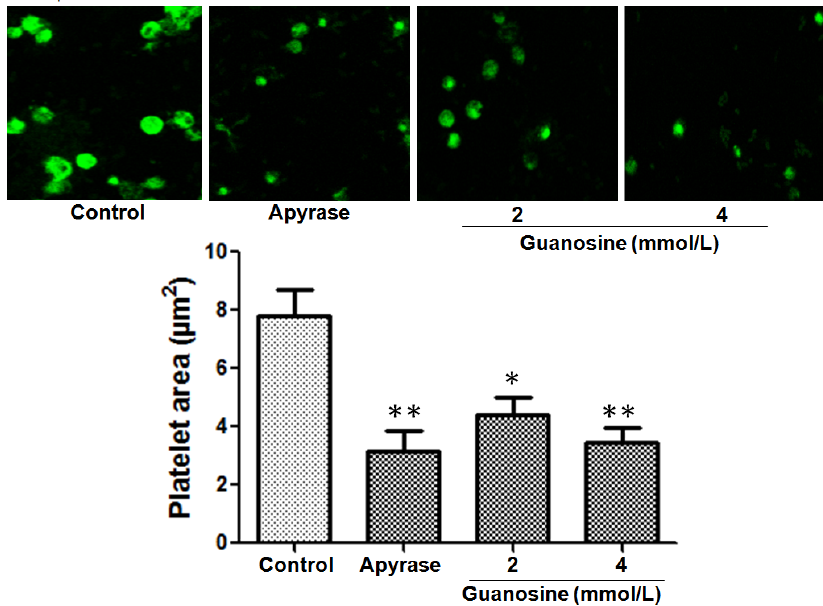
Figure 4. Effect of guanosine on spreading of human platelets on collagen-coated surfaces. Platelet area (µm 2 ) mean ± SEM was acquired from 4 consecutive fields using a Carl Zeiss LSM 700 confocal microscope. Control corresponds to saline: maximum spread. * p <